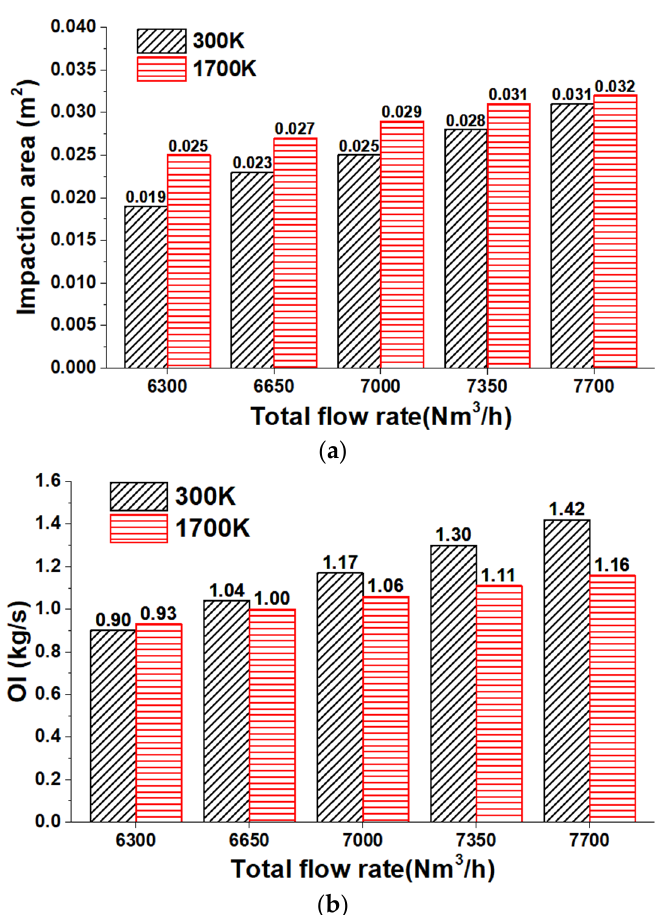
Figure 7. The impact area and the OI distributions at a lance height of 1550 mm: ( a ) impact area; ( b ) OI.